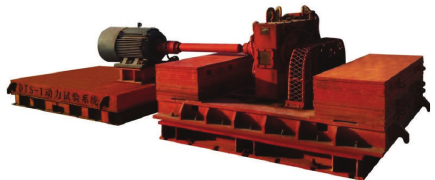
Figure 7: The structure of the vibrating